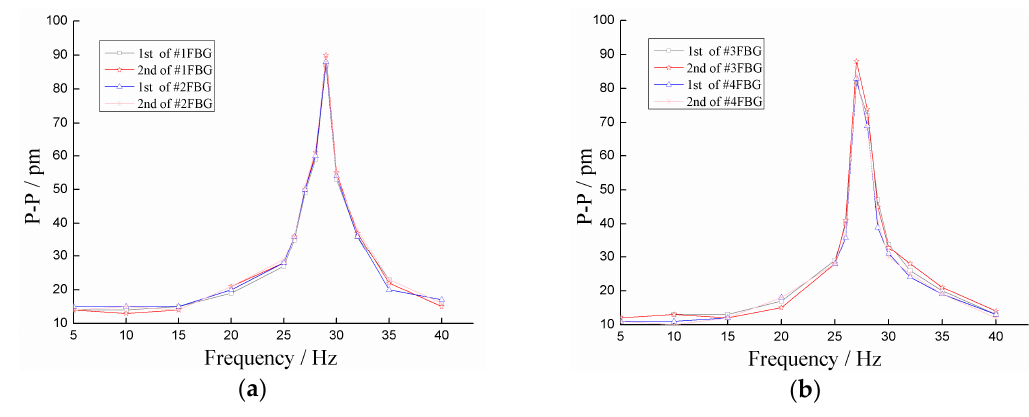
Figure 8. ( a ) Amplitude-frequency curves of #1 mass ball optical fiber system. ( b ) Amplitude-frequency curves of #2 mass ball optical fiber system.